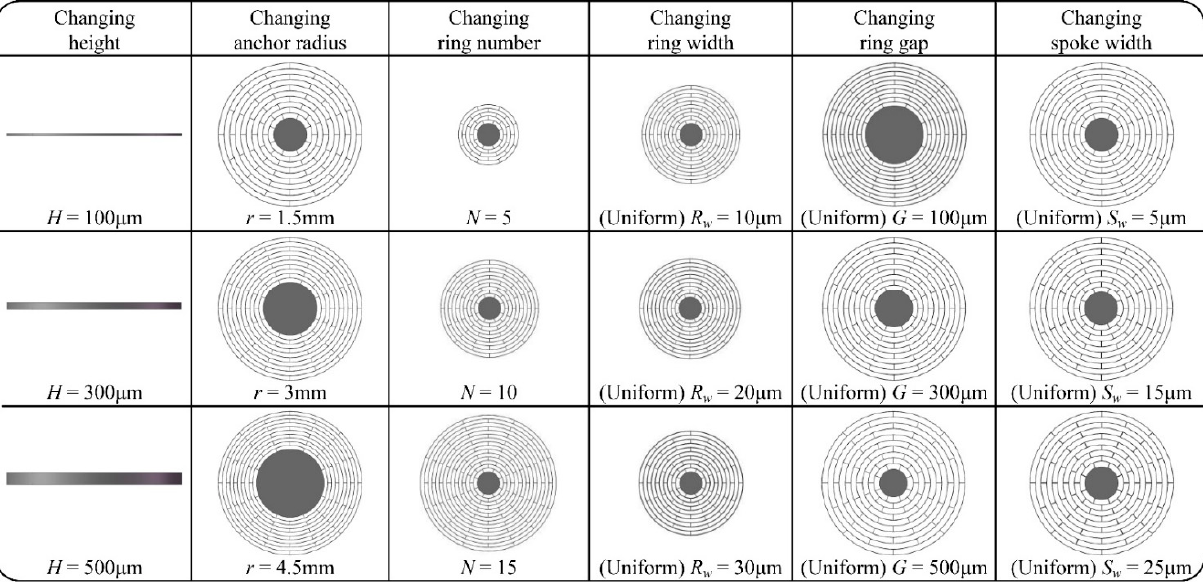
Figure 2. Typical structure examples of the disk MEMS resonator with only one single structural parameter changed.